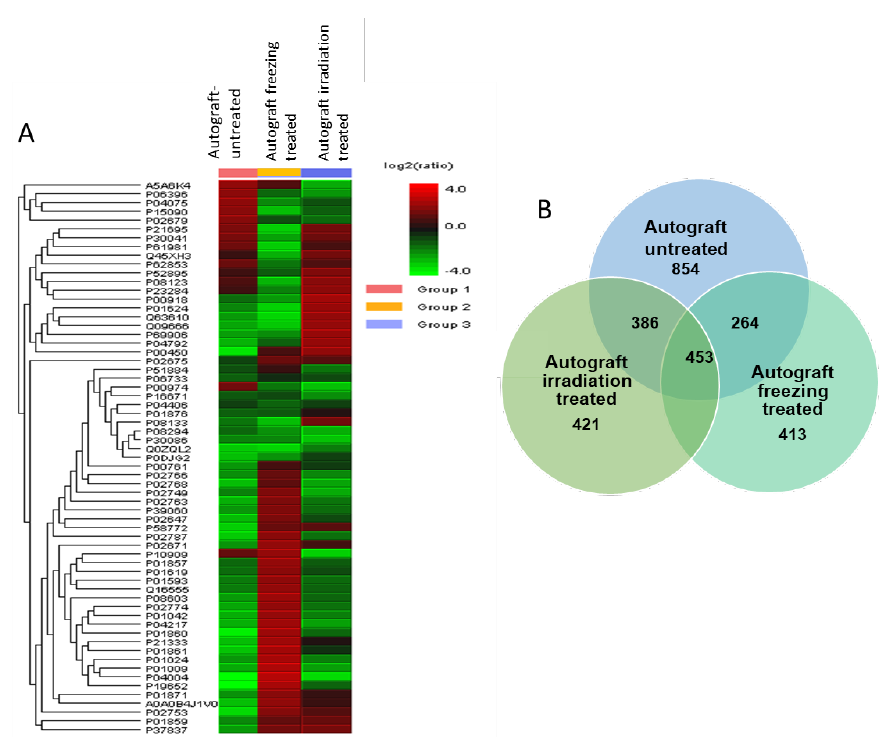
Figure 2. ( A ). Heatmap showing the protein expression changes among the treated and untreated autografts, ( B ). Ven diagram illustrates the identified proteins in individual groups and the overlapped proteins among them.